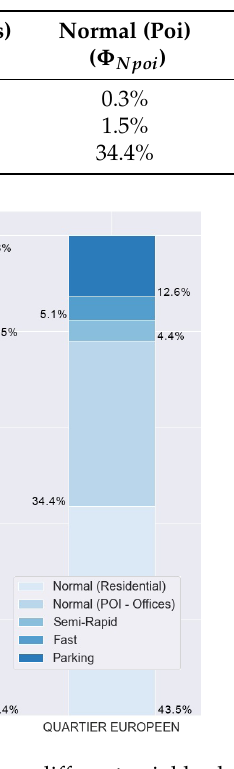
Table 4. Segmentation results for four different neighborhoods. Normal (Res) represents the residen- tial normal charging demand while the normal (Poi) represents the office normal charging demand.